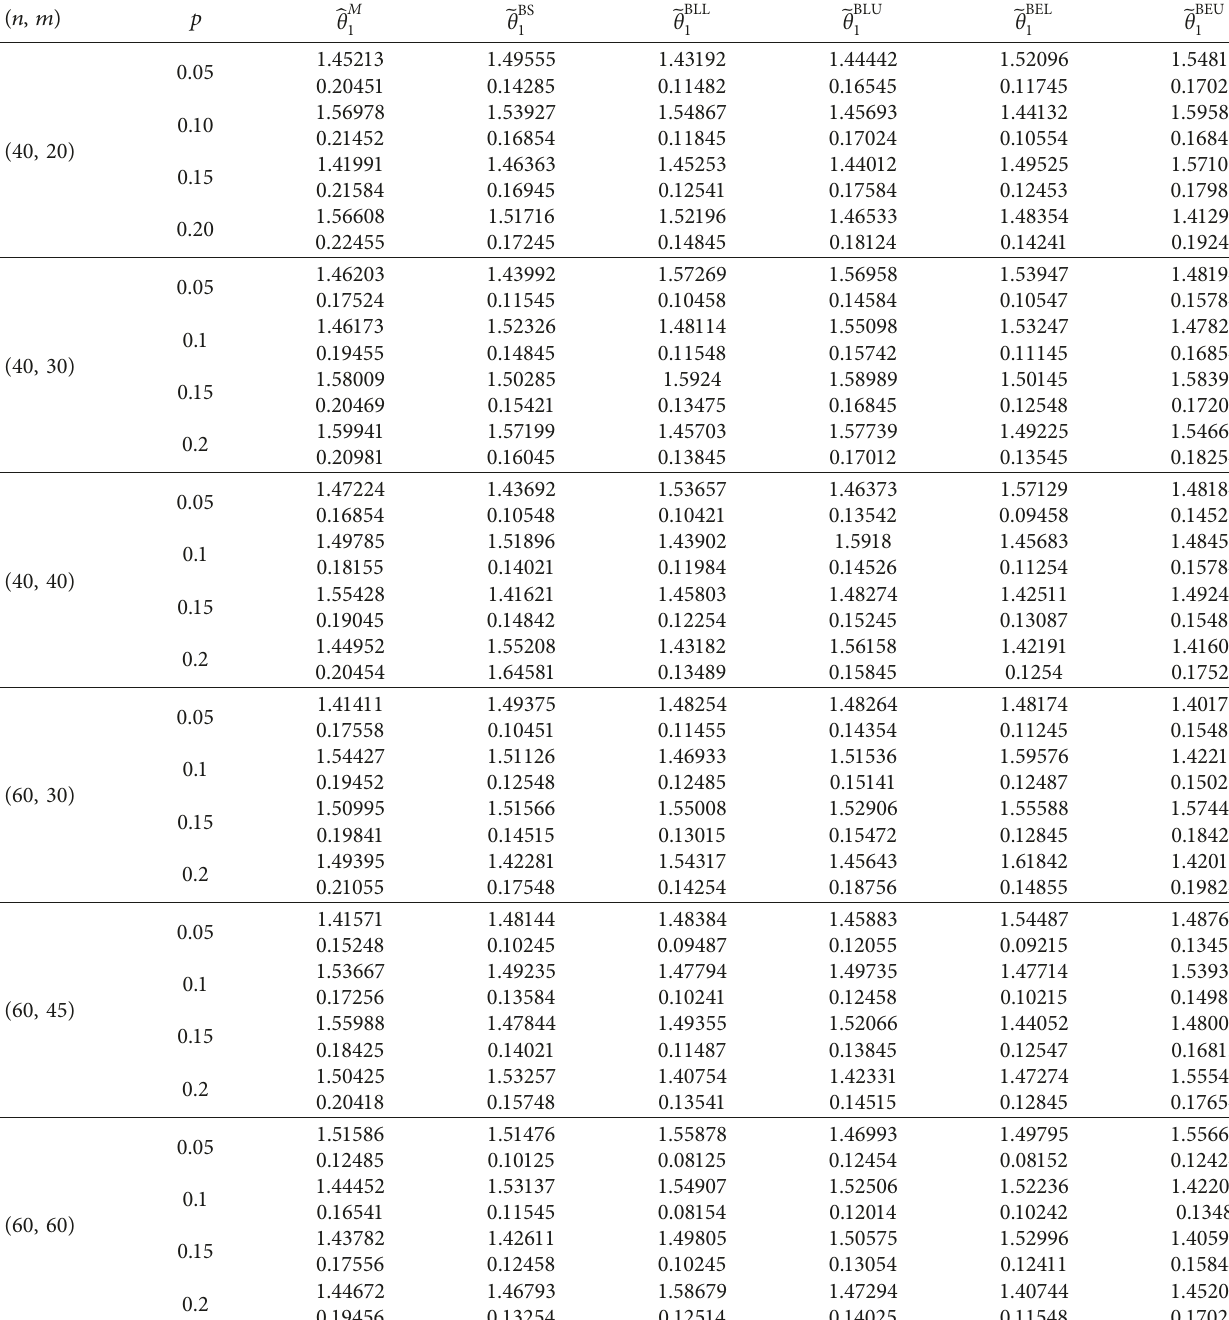
with respected MSE’s for different values of p and m for n 1